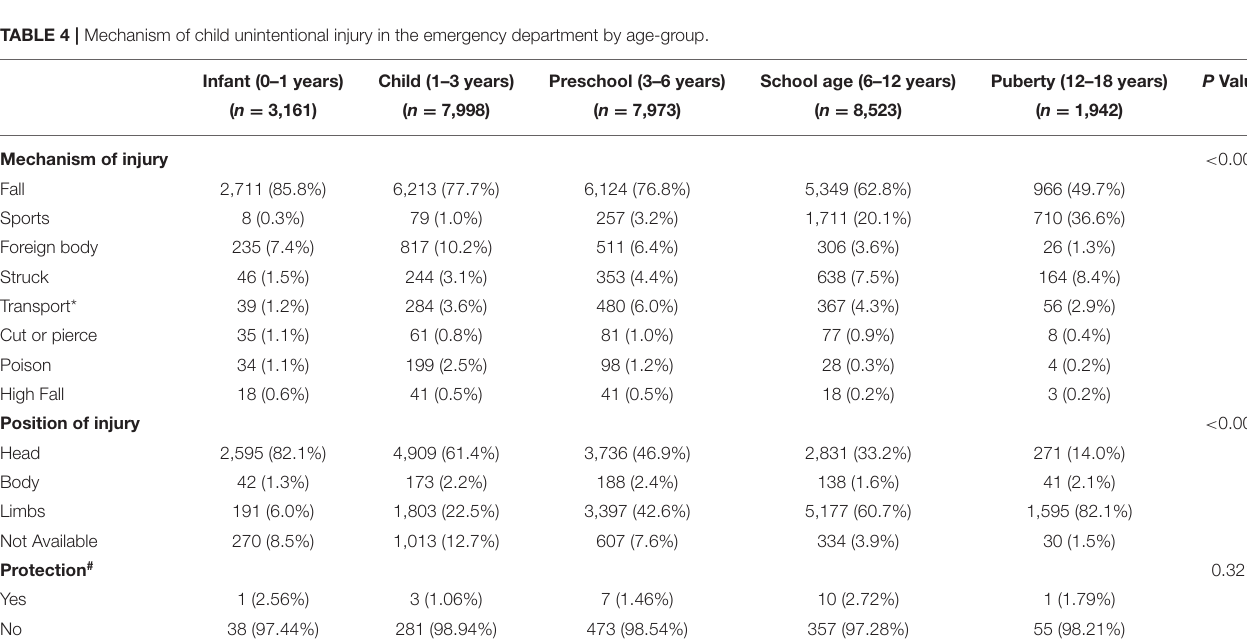
FIGURE 1 | Mechanism of child unintentional injuries by gender in the emergency department. Gender was colored by green (boys) and orange (girls). X row represents the mechanism of child unintentional injuries. Y row represents the count of injuries.